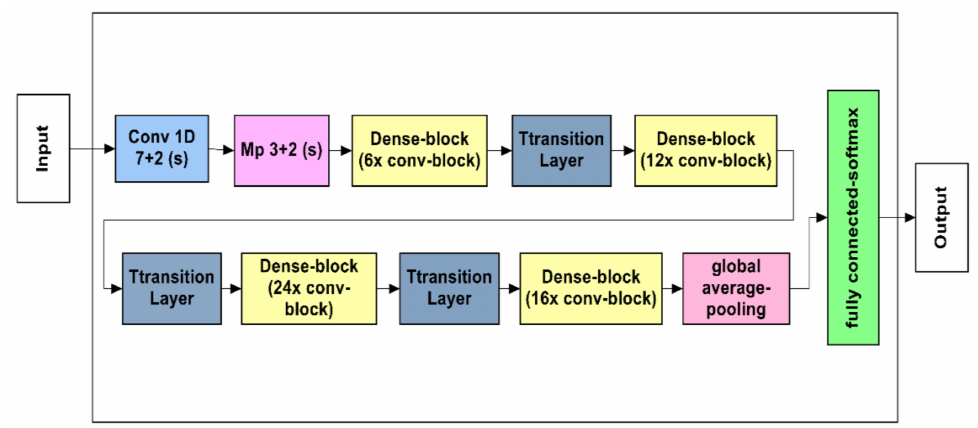
Figure 1. DenseNet121